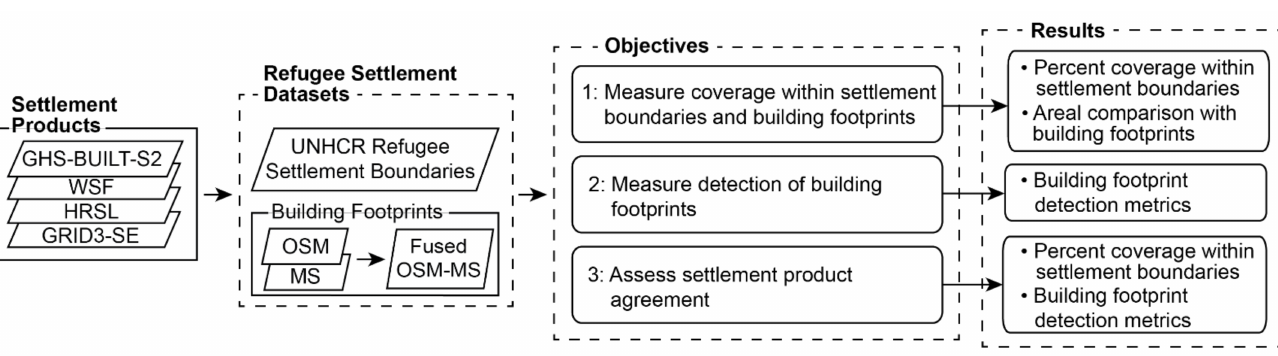
Figure 5. Methodological flowchart. GHS-BUILT-S2, Global Human Settlement Layer with Sentinel 2; WSF, World Settlement Footprint; HRSL, High Resolution Settlement Layer; GRID3-SE, Geo-Referenced Infrastructure and Demographic Data for Development settlement extent data; OSM, OpenStreetMap; MS, Microsoft.